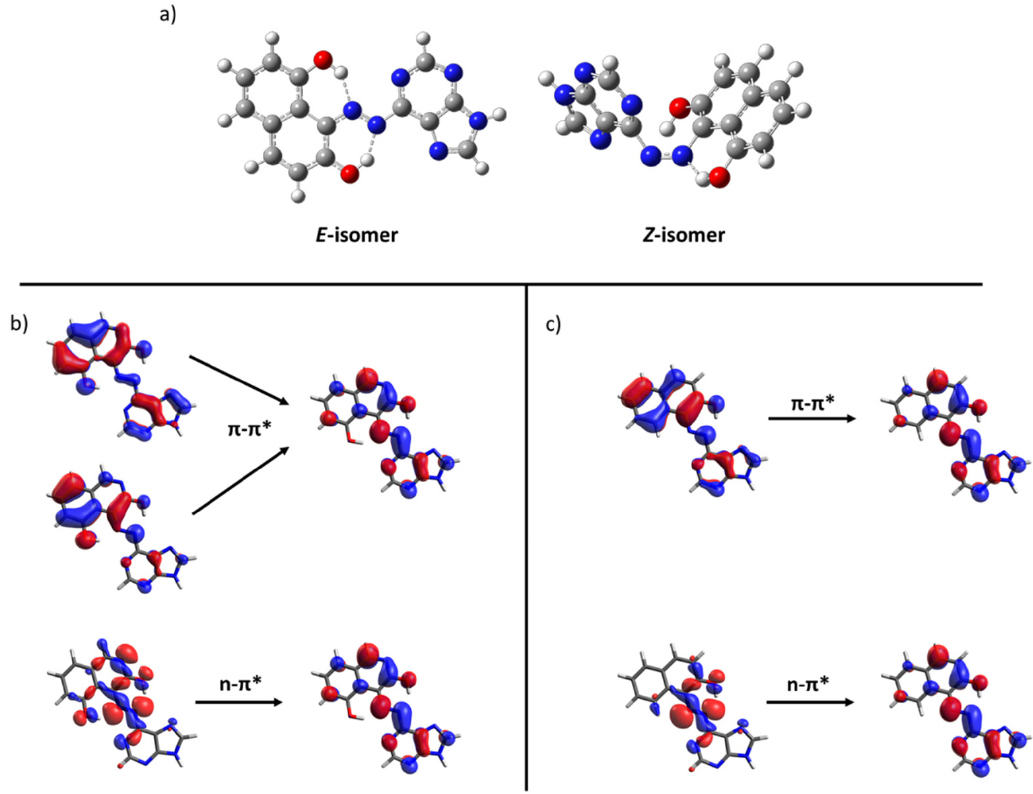
Figure 7. ( a ) Optimized structures of the E and Z -isomers of 67 . Representative orbitals involved in the excitation of azoheteroarenes 66 ( b ) and 75 ( c ).